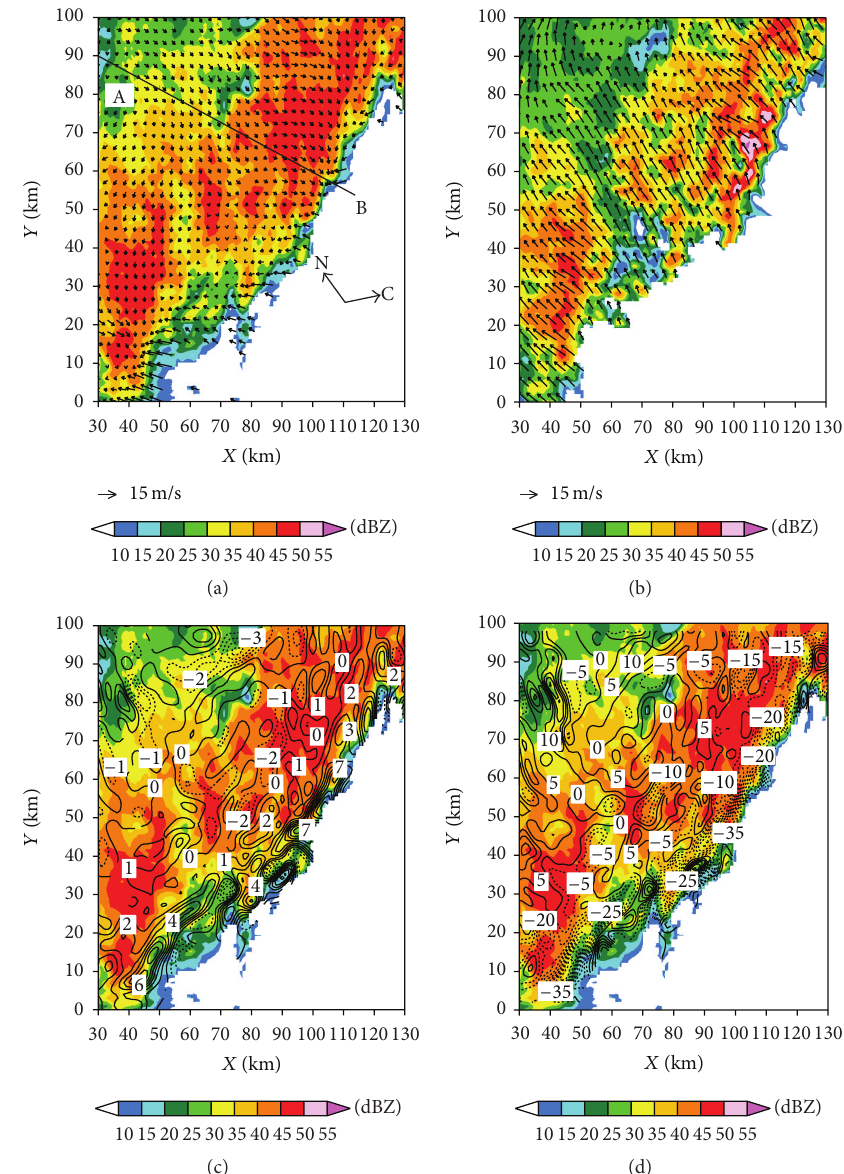
Figure 11: (a-b) The storm-relative horizontal wind fields at 1.75 and 5 km, respectively, at 1023 LST 24 April 2007. (c) The vertical velocity at 1.75 km. The solid lines are the updraft, and the dashed lines are the downdraft. (d) The divergence field (10 −4 s −1 ) at 1.75 km. Solid contours are for positive values (divergence) and dashed contours for negative value (convergence); the contour interval is 5 × 10 −4 s −1 . The colour shading is radar reflectivity